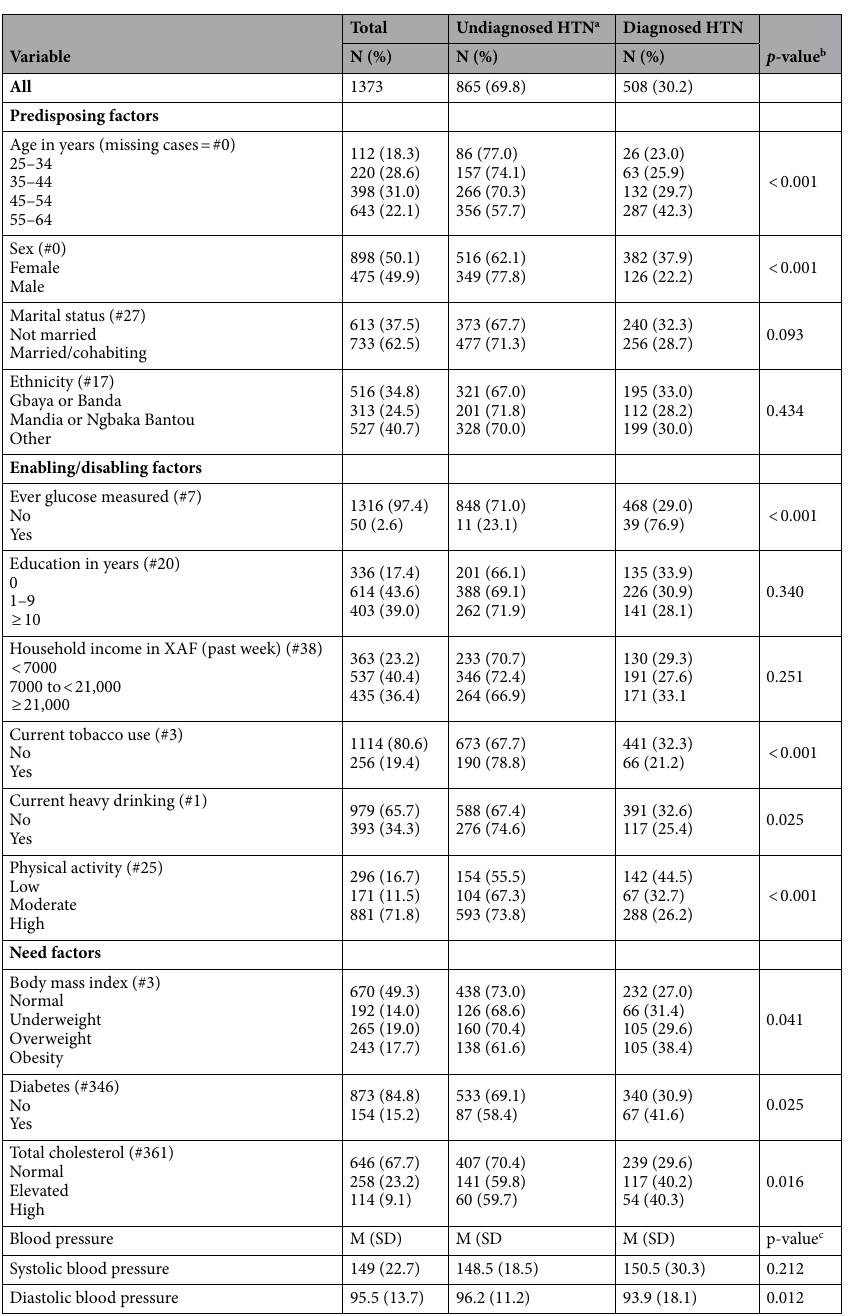
Table 1. Characteristics and predisposing, enabling/disabling and need factors in a sample of 1373 adults screened for undiagnosed and diagnosed hypertension (HTN) in Central African Republic, 2017 (%